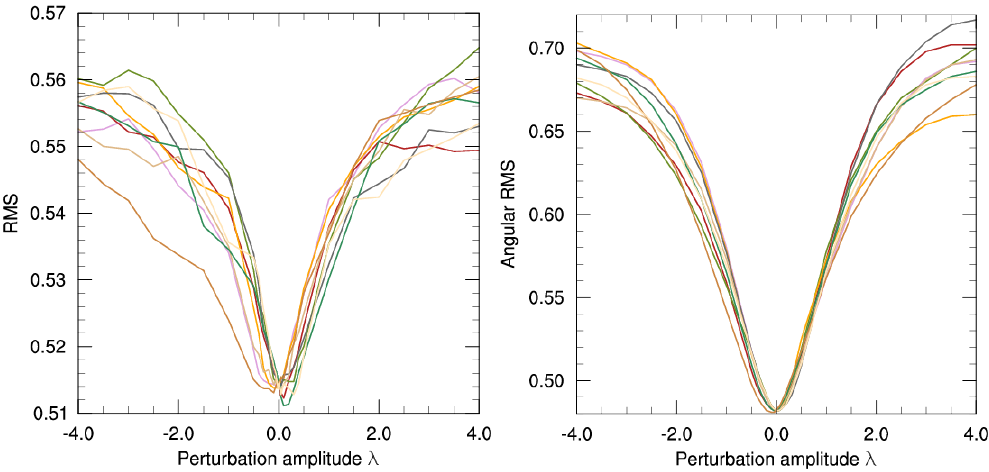
Figure 11. Sensitivity of the misfit between BFTLEs (BFTLVs) and SST fields with respect to the amplitude of nine random perturbations applied to a reference velocity field. Left panel: misfit between BFTLE and SST fields computed in the space of binary images (after the application of the image-to-structure operator). Right panel: angular misfit between BFTLV and SST gradients.